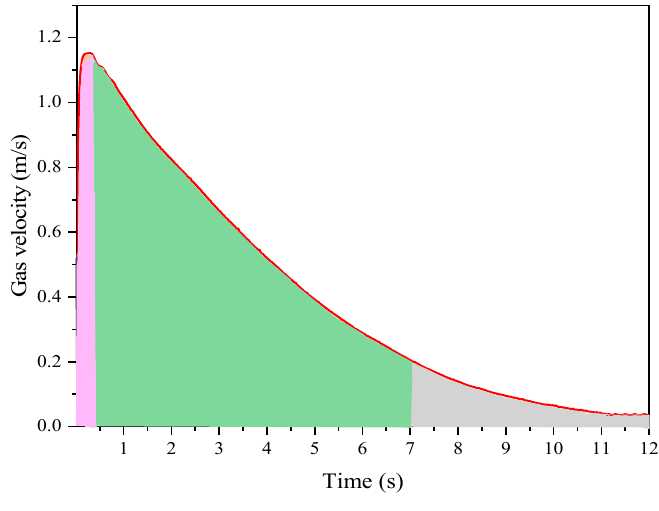
Figure 3. Velocity of gas phase.